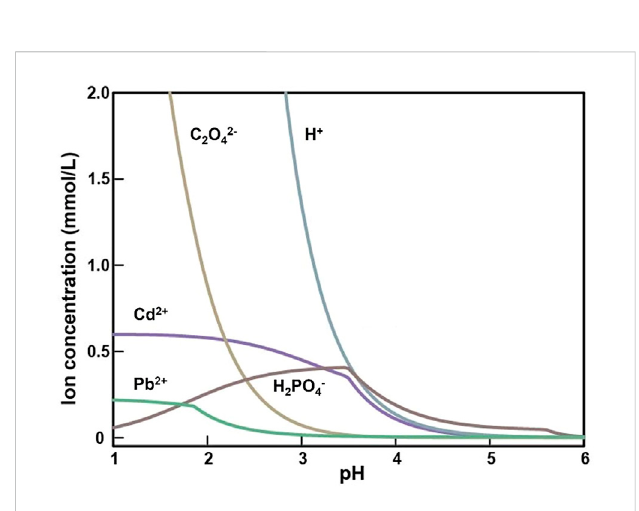
The concentration curve of the main ion species varying with pH value after 5 days incubation in the TPbCd